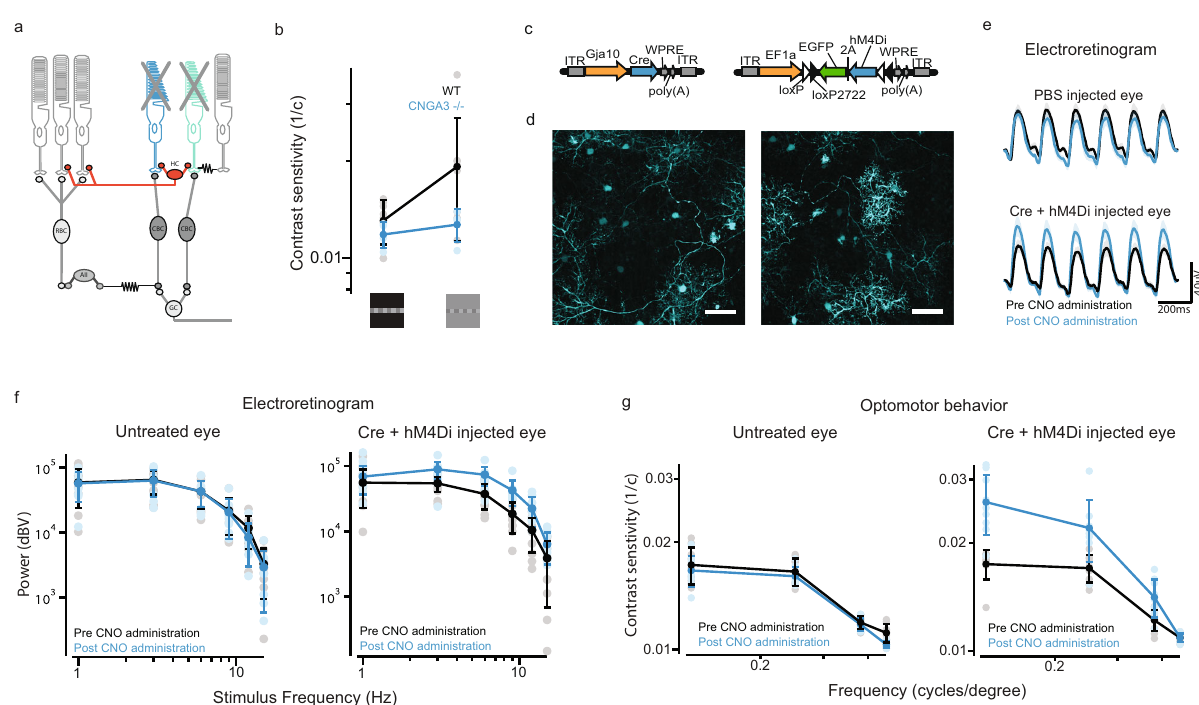
Fig. 4 Restoration of lateral feedback to rod photoreceptors improves vision in a mouse model lacking cone function. a Schematic showing the loss of cone derived lateral feedback from H1 horizontal cells in a mouse model of achromatopsia. Horizontal cells would normally provide cone-driven feedback to laterally displaced rods, directly modulating their output onto cone pathways. b Contrast sensitivity measurements were obtained for wild-type (black trace, n = 8 mice) and Cnga3 − / − ( n = 4 mice, blue trace) using a modi fi ed optomotor behavior paradigm driven by a 1° height sinusoidal stimulus